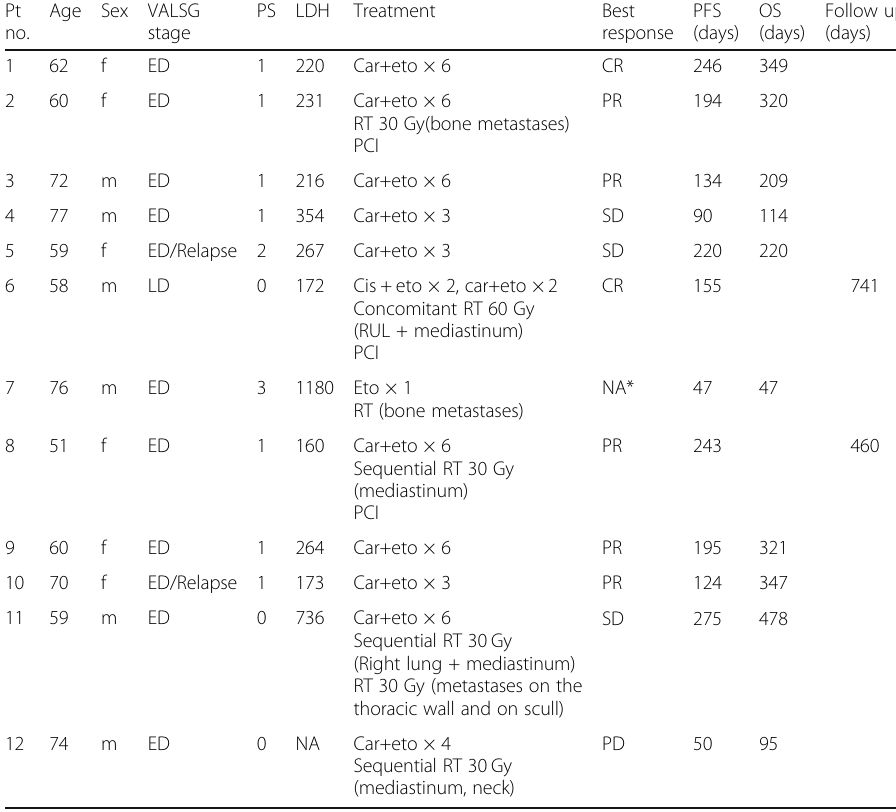
Table 1 Patient characteristics and outcome Pt Age Sex VALSG PS LDH no. stage